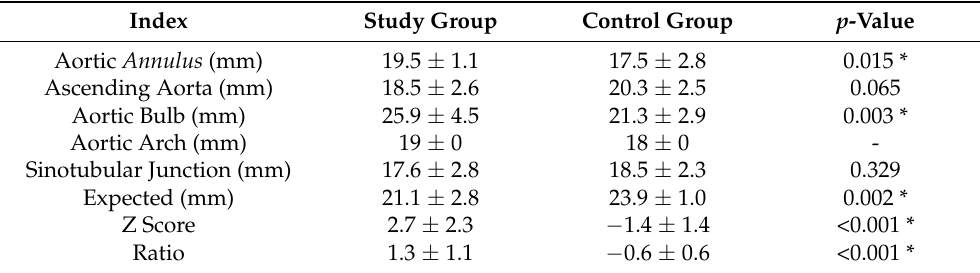
Table 2. Echocardiography-derived sizes.